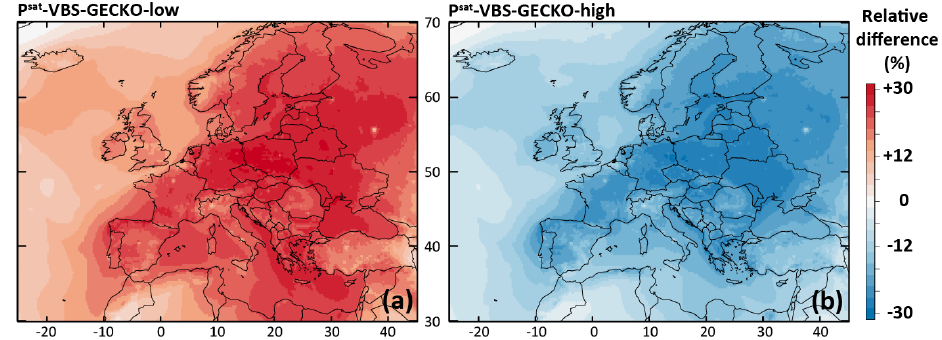
Figure 9. Relative difference in the simulated mean OA concentrations between (a) the P sat -VBS-GECKO-low and the ref-VBS-GECKO model configurations and (b) between the P sat -VBS-GECKO-high and the ref-VBS-GECKO model configurations for the 2-month period.